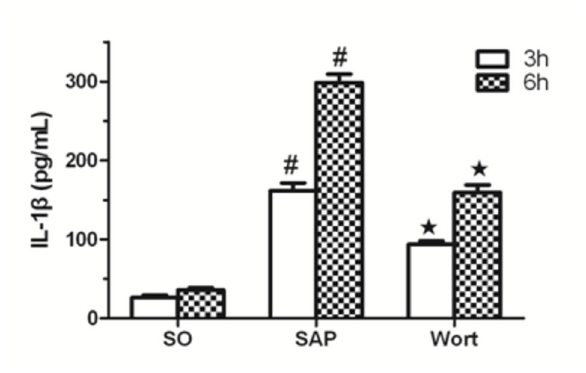
Figure 5. IL-1β level in each group at the 3 h and 6 h time point. # P <0.05 vs. SO group; ★ P <0.05 vs. SAP group.